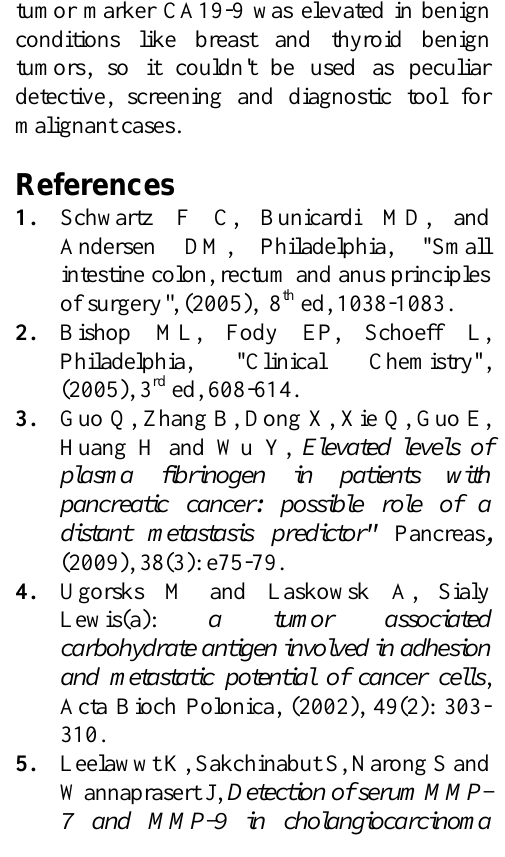
Table (2):- CA19-9 value in sera and tissues of patients groups Serum Tissues Mean Group P Value Mean ± SD ± SD Breast benign 15 ±1.58 356.21 ±173.75 4.7*10 -4 patients Thyroid benign 10.67 ±2.08 20 ±14.4 patients